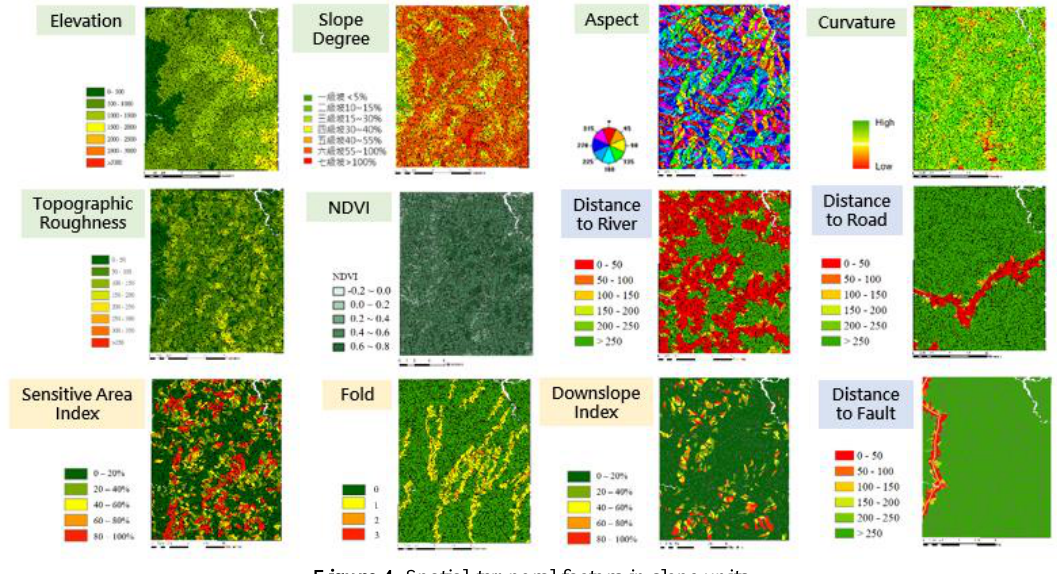
Figure 4. Spatial-temporal factors in slope units. Table 1. Spearman correlation coefficient test between selected factors and